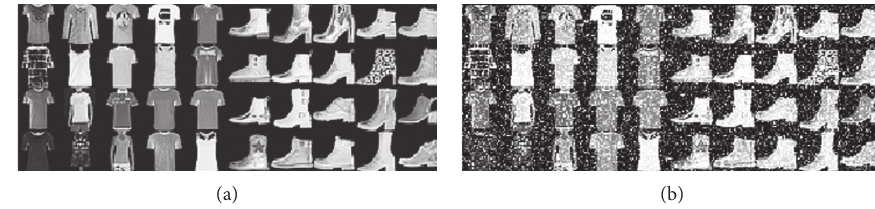
Figure 19: Examples of original “T-shirt” and “boots” and images with added noise.